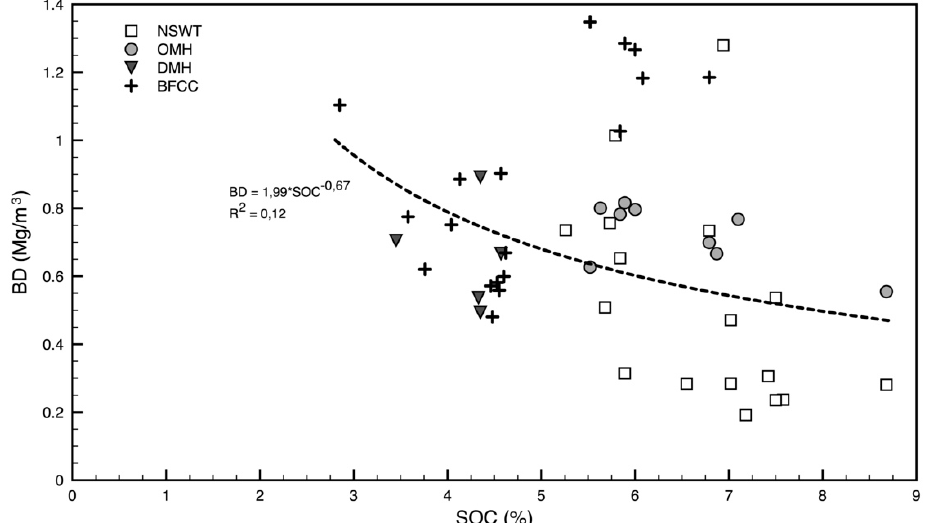
Figure 3. Relationship between soil organic carbon (SOC) concentration and bulk density (BD) at a 0–30 cm depth of the soil, in the four dominant land uses at Santuario de Fauna y Flora Iguaque in Boyacá, Colombia. NSWT: natural grasslands prevailingly without trees and shrubs; OMH: open heathlands and moorlands; BFCC: broad-leaved forests with continuous canopy, not on mire; DMH: dense heathlands and moorlands. Pointed line represents the best fit model.